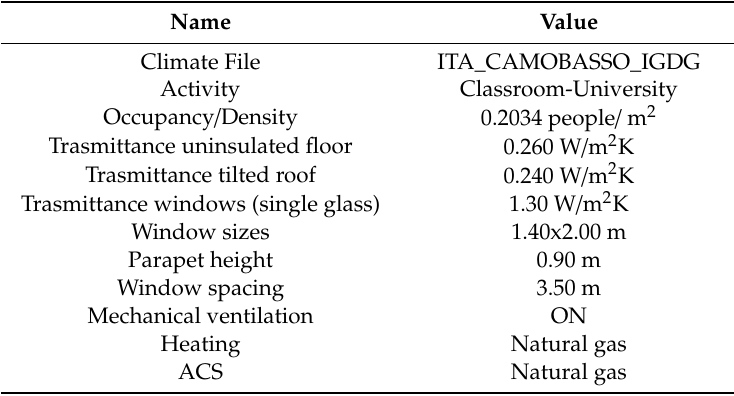
Table 7. Input data of the DesignBuilder model for the scenarios.